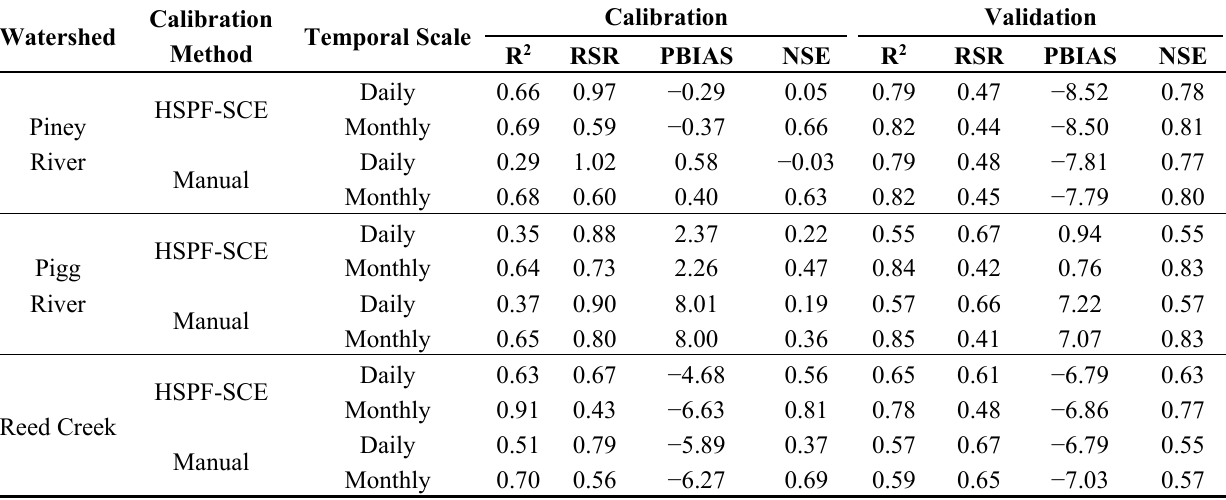
Table 9. Comparison of the model performance achieved by the calibrated parameters in terms of common goodness-of-fit